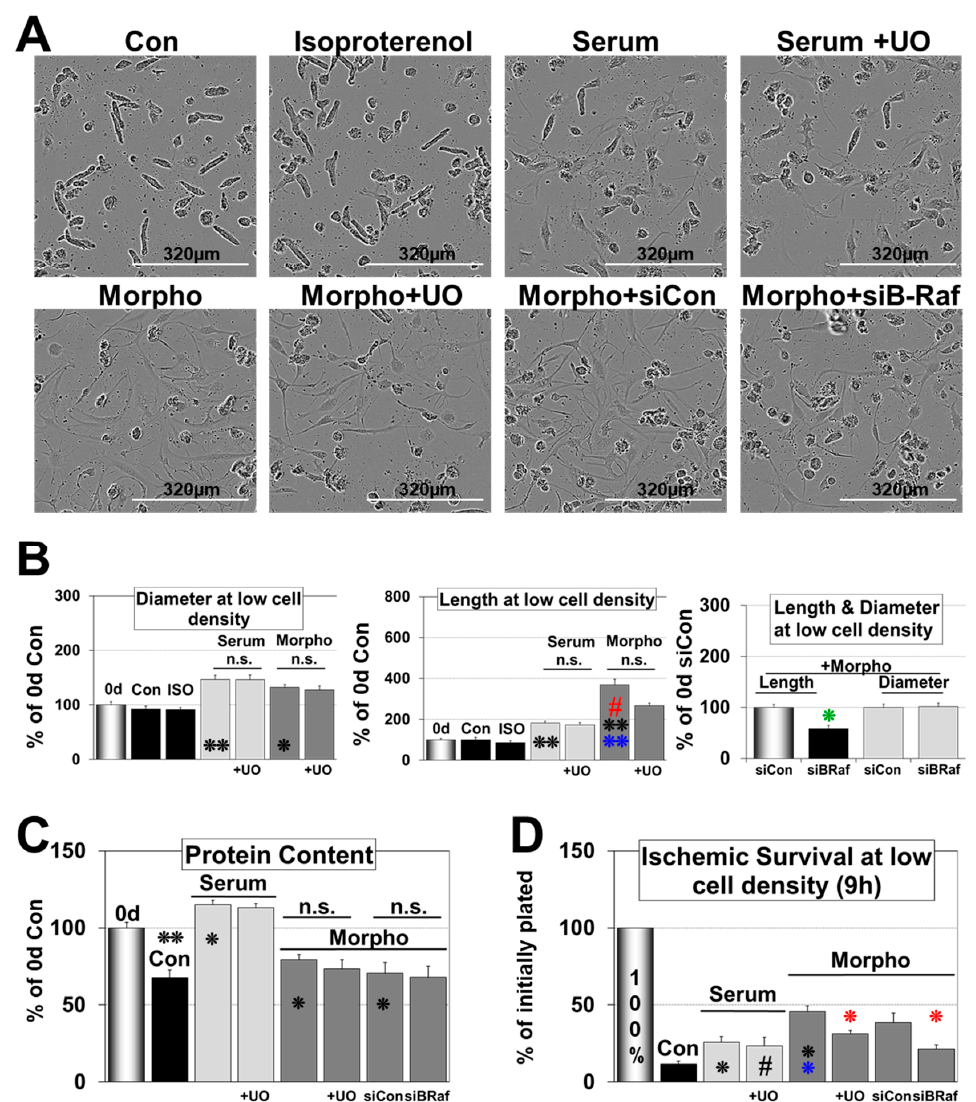
Figure 3. Fetal remodeled but not hypertrophic cardiomyocytes show MAPK dependent ischemic resistance. Primary cultures of adult cardiomyocytes were untreated (Con) or treated with isoproterenol (ISO), serum (Serum), and morphogens (Morpho) for 6 days. Cardiomyocytes were seeded at low density except in ( C ). UO126 (5 µM) was added (+UO) 1 h before experimental start. Note that cultures were pretreated with siRNA (siCon, siBRaf) three days before experimental start. Single and double stars indicate p < 0.01 and p < 0.001, respectively. Hash signs indicate p < 0.05. Black signs refer statistically to the 0 d group, blue signs to serum, and red compares Morpho (Morpho, Morpho siCon) statistically with and without UO/siB-Raf (+UO, siBRaf). The green star refers to the siCon group. ( A ) Phase-contrast images of cardiomyocyte cultures. ( B ) Quantitative and statistical evaluation of cell length and diameter of ( A ). ( C ) Total protein content of 6 d-treated cultures at high cell density were compared with cardiomyocytes at experimental start (0 d). ( D ) Cardiomyocytes were pretreated for 6 days with 0.2 mg/mL albumin (Con), serum, serum + UO126, morphogen, morphogen + UO126. At the end of a 6-day culture period, all cells were counted (reference value 100%) and then kept in glucose-free PBS at 1% O 2 . After 9 h of ischemia, cardiomyocytes were fixed in 4% paraformaldehyde and recounted. Morphogens, but not serum, induced ERK1/2 phosphorylation after 10 min and SM-actin reexpression after 6 days. MAPK activation and SM-actin reexpression were strongly reduced by the